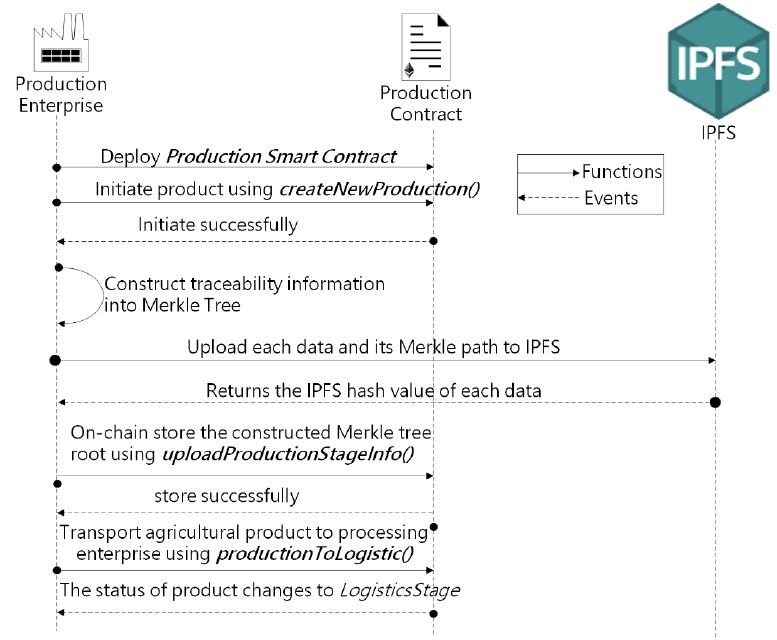
Figure 7. Sequence diagram showing interactions among the production enterprise with the Production smart contract.